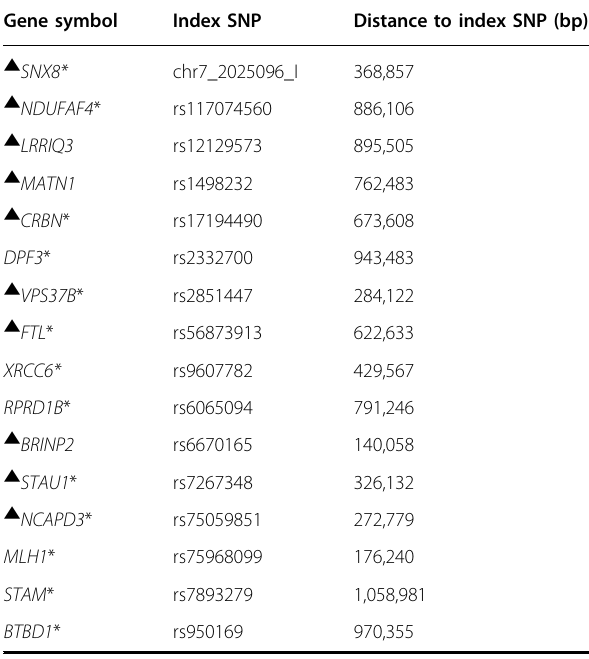
Table 2 Novel SCZ risk genes predicted by